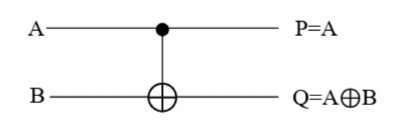
Figure 7. The quantum implementation FG.